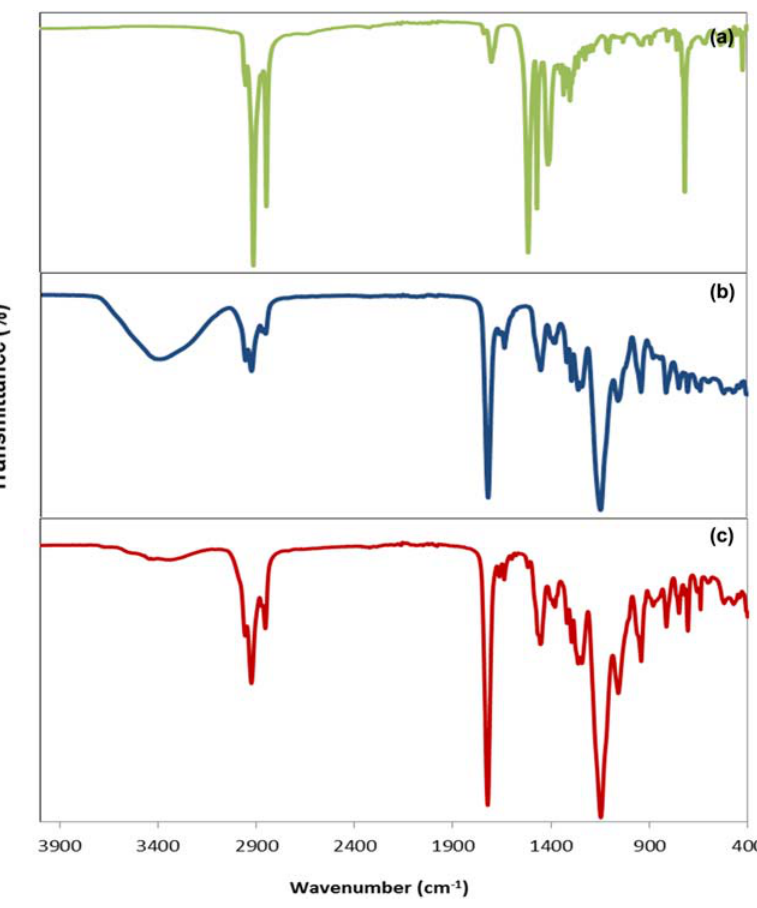
Figure 3: FT - IR spectra of ( a ) AgStNPs, ( b ) bare organic monolith, and ( c ) AgStNP – methacrylate polymeric